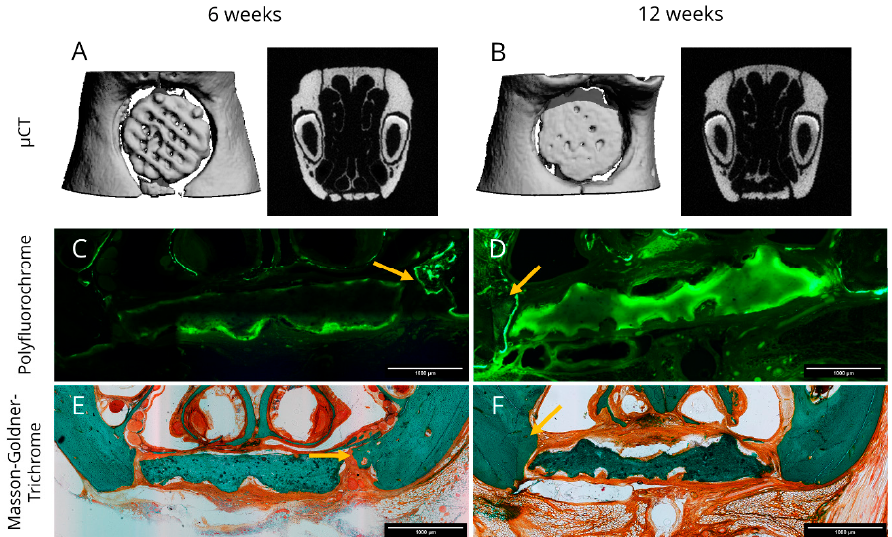
Figure 5. Representative images obtained from microcomputed tomography data ( A , B ) as well as fluorescence ( C , D ) and light ( E , F ) microscopy of histological sections of explants. ( A , C , E ) represent a healing time of 6 weeks and ( B , D , F ) a healing time of 12 weeks. Histological sections were labelled with polyfluorochrome dye (Calcein, C , D ) prior to sacrifice and after microscopical analysis, Masson-Goldner-Trichrome stainings ( E , F ) were applied to the same sections. Arrows mark zones of newly formed bone tissue. Scale bars represent 1000 µm.